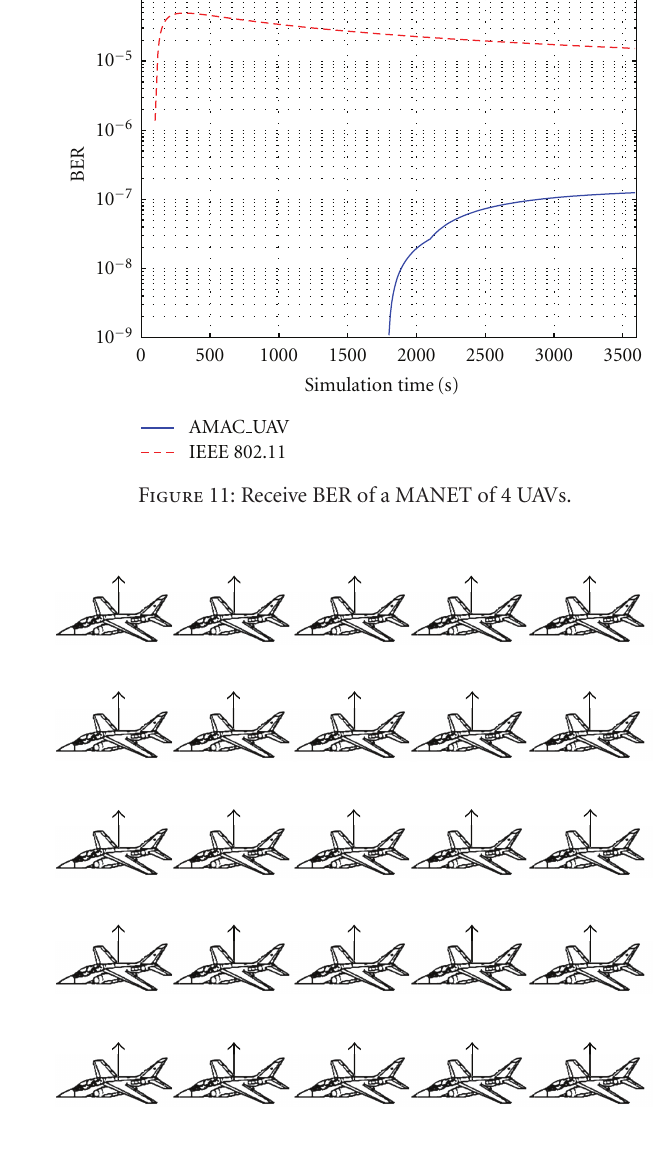
Figure 12: Initial topology of a MANET of 25